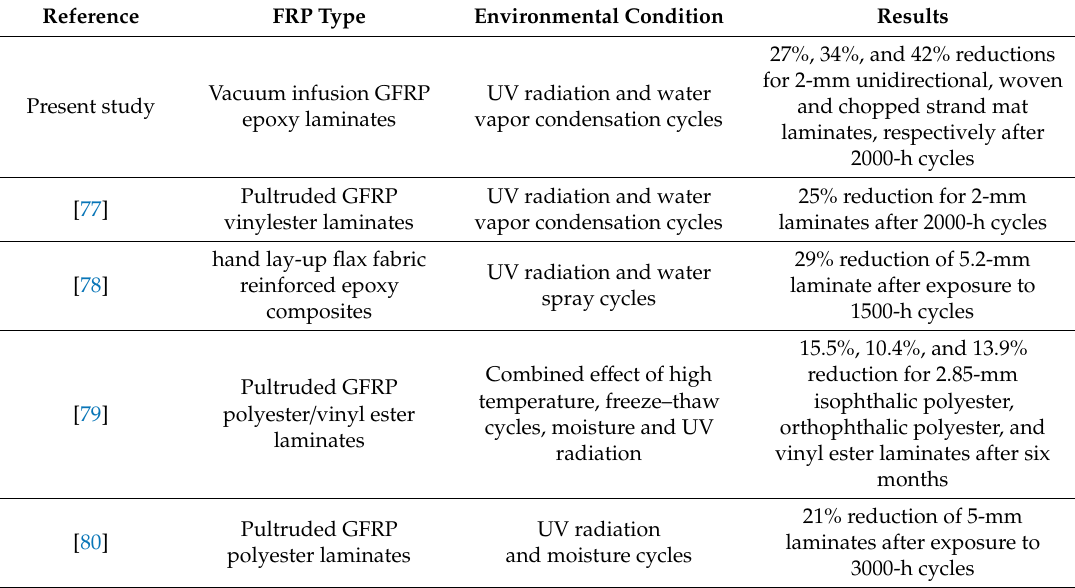
Table 4. Test results of the present study and other research under UV radiation and moisture